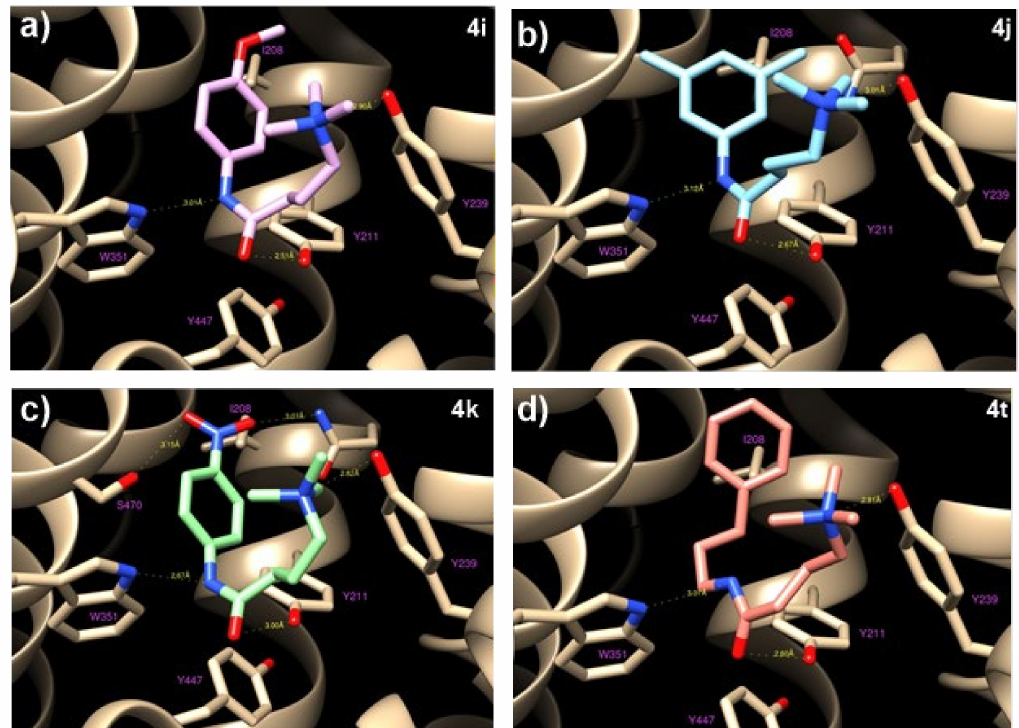
Figure 4. The binding modes of the di ff erent ligands tested, resulting from docking simulations. The receptor hOCTN2 is depicted by tan ribbons, and all the ligands are sticks. The residues involved in protein-ligand interactions are drawn as shapes and sticks. ( a , b ) The binding mode for 4i (pink sticks) and 4j (light blue sticks); 4k is in green in ( c ); ( d ) molecule 4t is shown in